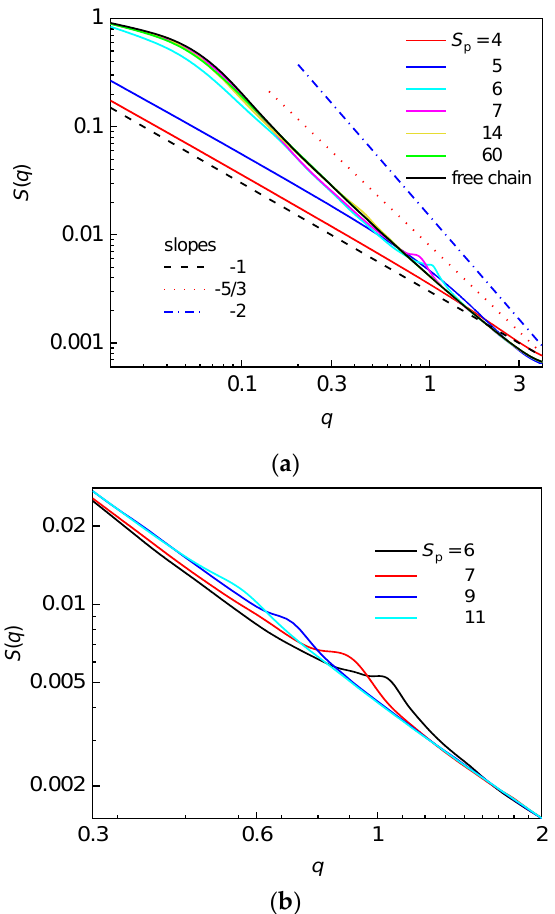
Figure 5. Structure factor for a flexible chain confined in an array of nanoposts of fixed post diameter d p = 3.9 and various post separations S p ( a ). The straight lines represent the characteristic slopes that might be expected for a flexible chain confined in a symmetric channel. Structure factor for a flexible chain in the interval of wavevectors q , where the hump characterizing the geometry of post array is developed ( b ).